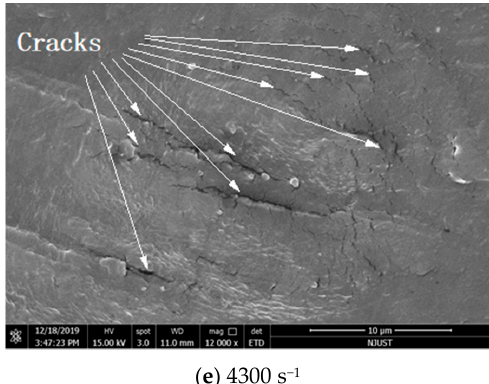
Figure 6. SEM images of UHMWPE specimens before and after the SHPB experiments. The UHMWPE chains were orderly arranged before the SHPB experiment, and the UHMWPE chains were bent at a compressive strain rate of 1300 s − 1 . As the strain rate increased, cracks were found in the UHMWPE chains, and with the further increase in the strain rate, cracks propagated and grew so that bulging appeared in the UHMWPE chains between cracks. As the strain rate reached 4300 s − 1 , this phenomenon became so obvious that the UHMWPE chains could not be identified. This implied that with the increase in the strain rate, the molecular mobility ratio of the UHMWPE chains decreased, and the molecular chains hardened, resulting in crack failure [27,28]. As observed by the electron microscope, the microscopic morphologies of the UHMWPE specimens at a strain rate of 1300 s − 1 and temperatures of 20–100 °C were not significantly different from that at room temperature. Thus, the microscopic morphology of the UHMWPE at other temperatures is not discussed in this paper.